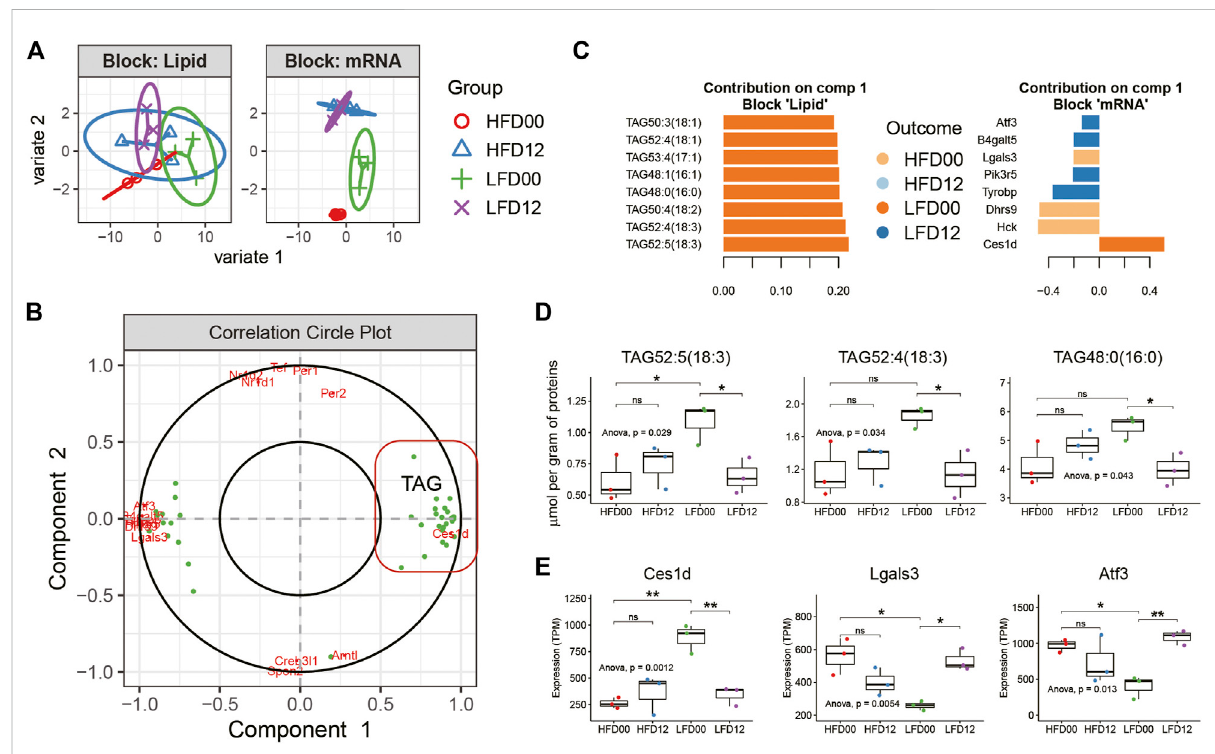
FIGURE 4 Multi-omics N-integrative supervised analyses in adipose tissue. (A) Clustering analysis of samples per data set. (B) Correlation Circle plot representing each type of selected features. Correlation coef fi cient > 0.6. (C) Loading plot of each feature selected on component 1 in each omics study, the color of which indicates the class with a maximal mean expression value. (D) Tissue concentration of representative lipid species in component1. (E) Expressionpro fi lesofrepresentativetranscriptsincomponent1.Dataarerepresentedasmean±SEMandjitteredpoints,one- way ANOVA and unpaired t -test, * p < 0.05, ** p < 0.01. TAG,